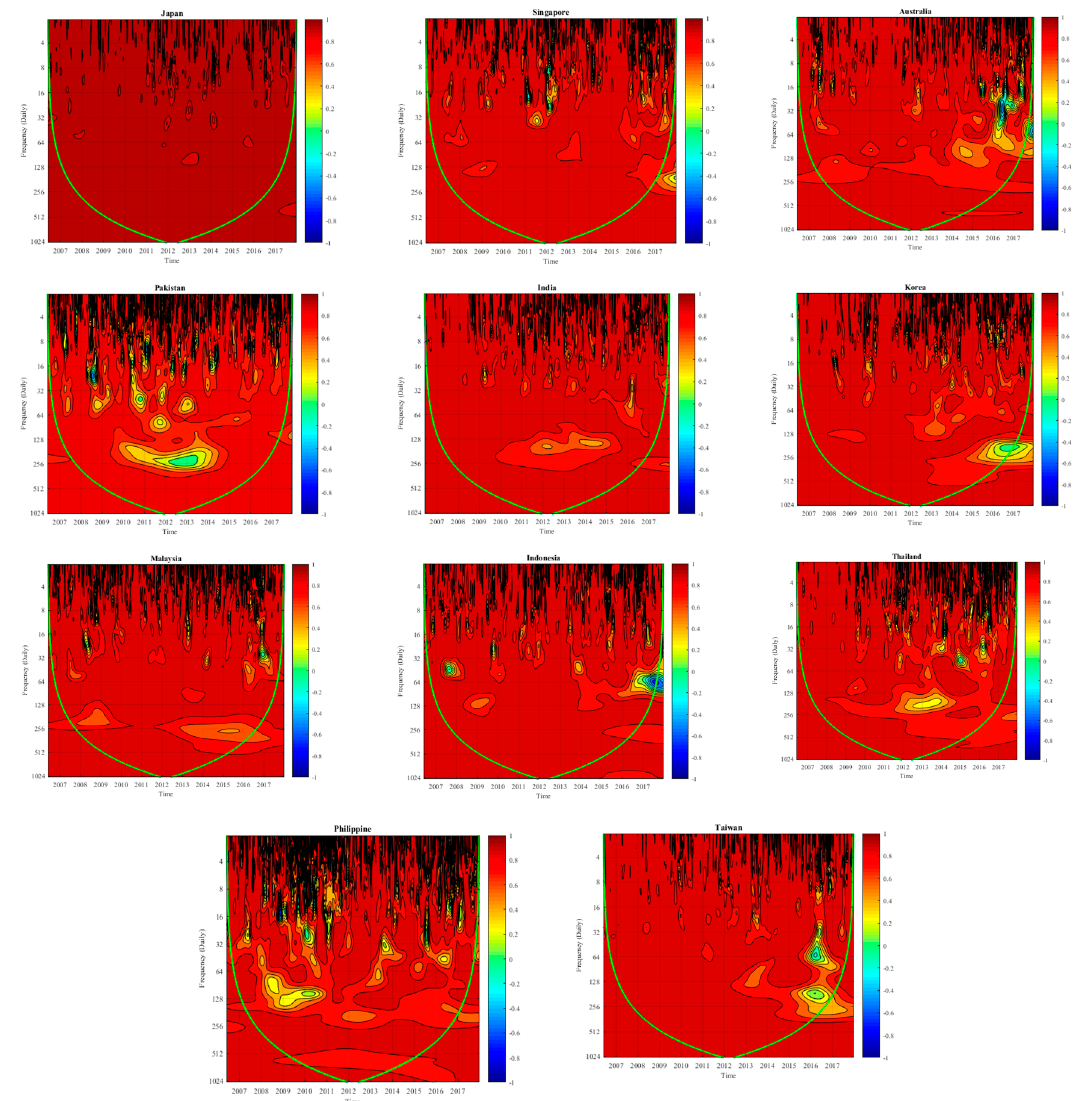
Figure A1. Islamic-conventional stock returns Wavelet correlations for Asia-Pacific region’s markets. The wavelet plots reported in Appendix A indicate that these Asian / Pacific Islamic and conventional equity markets are highly and positively correlated to each other at all frequency scales and over time. This evidence suggests the rejection of the decoupling hypothesis or the evidence of integration between the Islamic and conventional markets. Thus, lower diversification benefits to portfolio